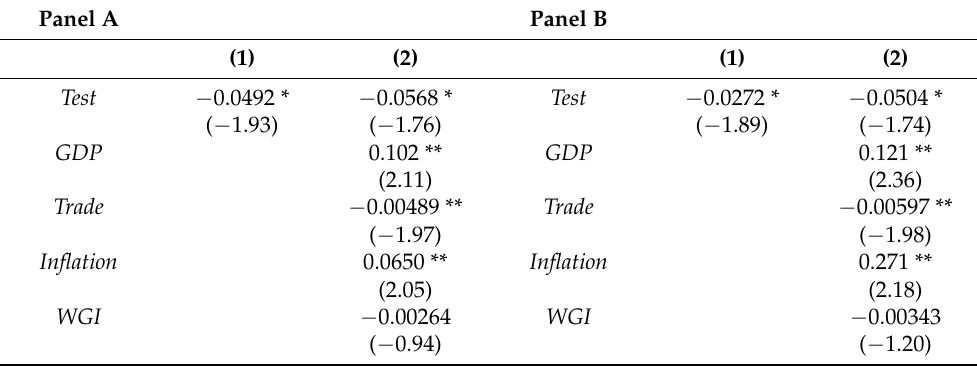
Table 4. This table shows the results of a difference-in-difference test using an OLS regression on the percentage change in the number of bids submitted across countries. In Panel A, the dependent variable is [diff]; the percentage change in the mean number of bids per year in each country before and after 2007. The main independent variable is [test], an indicator variable that equals 1 if a country falls in the test sample. Macro-economic control variables have been included in model 2. Panel B shows the results of the same test performed, where late adopters are defined as countries where social media became popular after 2009